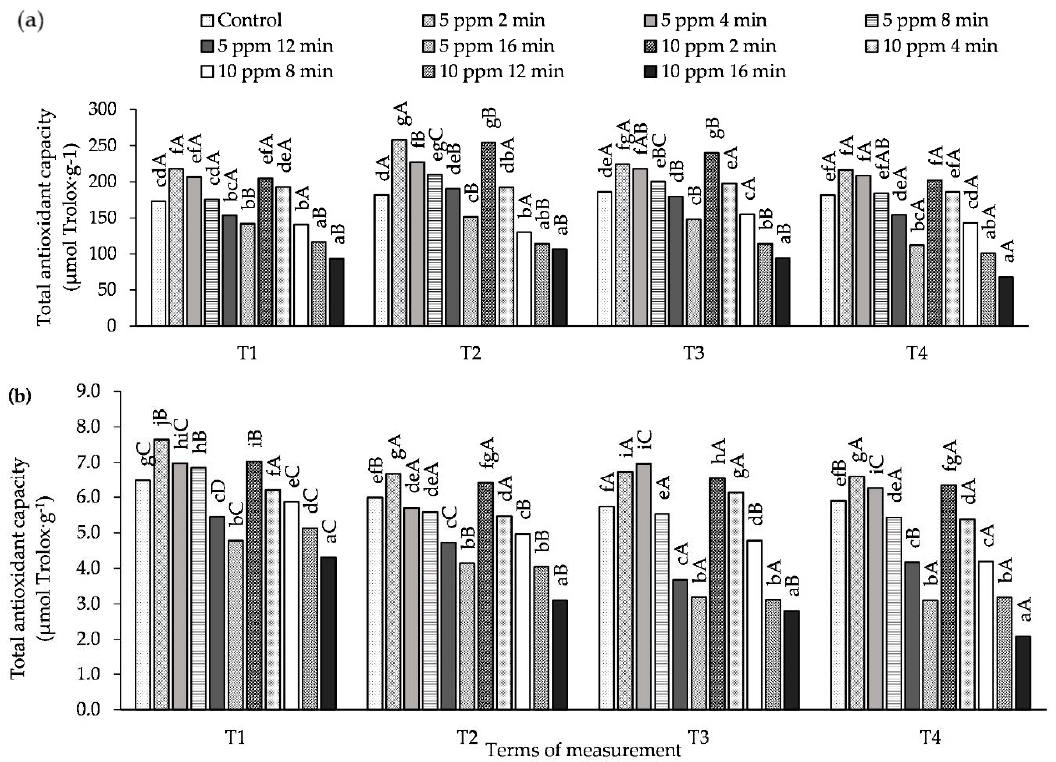
Figure 4. Changes in the total antioxidant capacity (AA) in potato leaves depending on O 3 concentration, exposure time and measurement terms (T1—1st day after the 1st fumigation, T2—7th day after the 1st fumigation, T3—1st day after the 2nd fumigation, T4—7th day after the 2nd fumigation); ( a ) method with ABTS •+ radical, ( b ) method with DPPH • radical. Lowercase letters